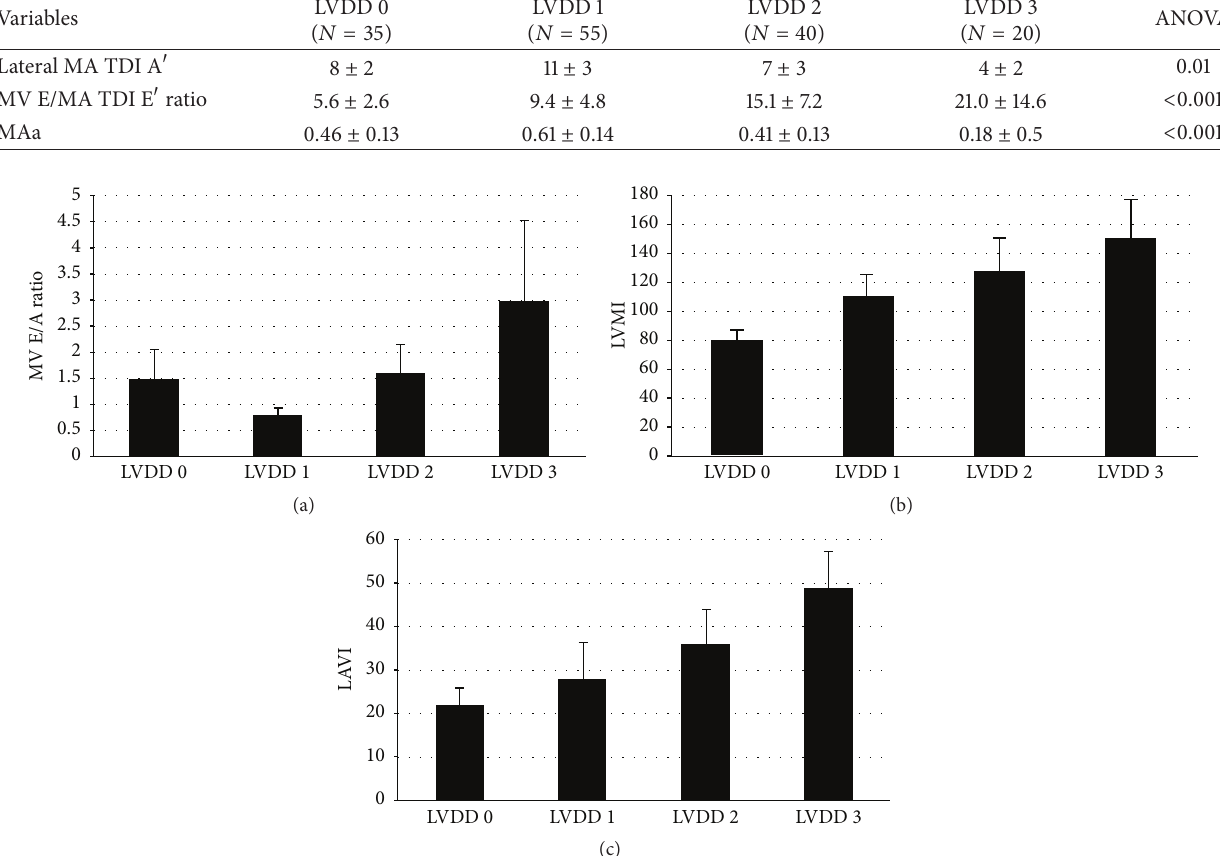
Figure 2: (a) Box plot showing MV E/A ratio mean and standard deviation values for each stage of LV diastolic function. (b) Box plot showing LV mass index (LVMI) mean and standard deviation values for each stage of LV diastolic function. (c) Box plot showing left atrial volume index (LAVI) mean and standard deviation values for each stage of LV diastolic